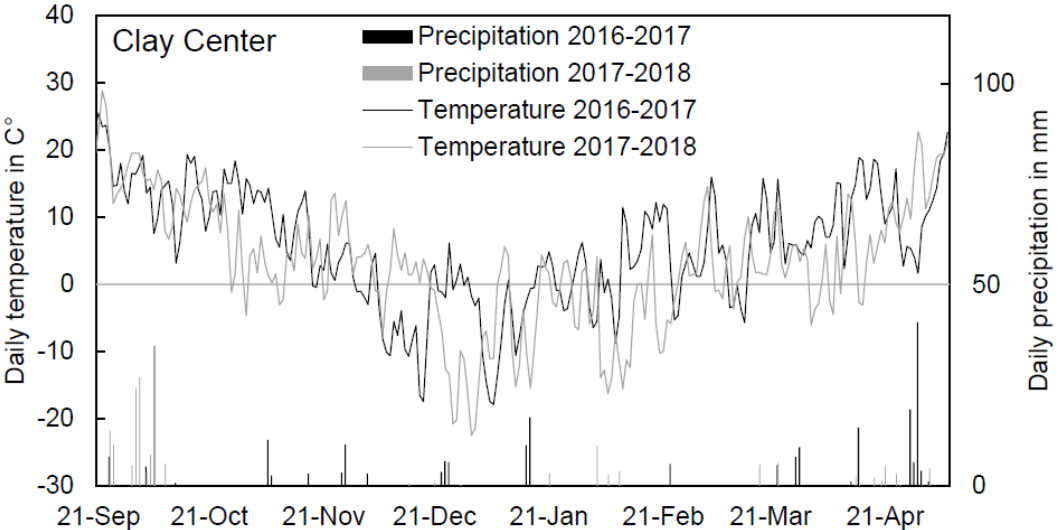
Figure 1. Daily average temperature (left axis, line graph) and precipitation (right axis, bar graph)